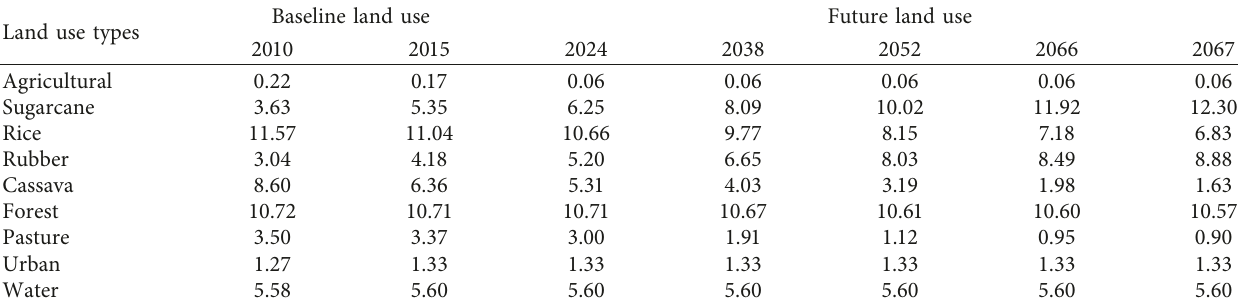
Table 8: Trends of land use change for baseline and future periods above the Huay Sabag area (km 2 ) by participation